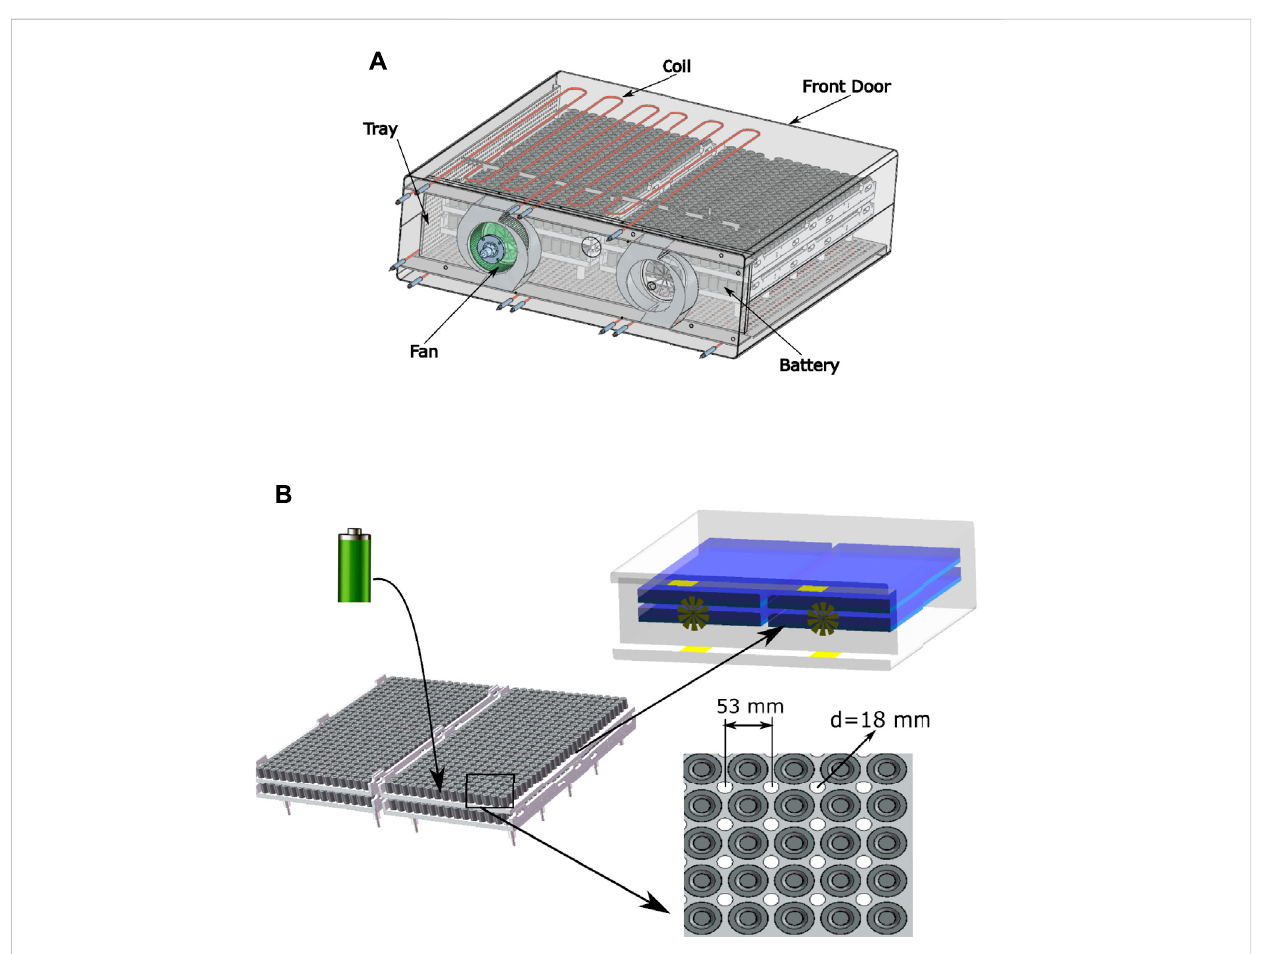
FIGURE 1 Illustrations of the drying cabinet investigated in the present work: (A) physical model that is mainly composed of fans, heating coils, porous plates, cylindrical batteries stacked on trays, and a front door for loading and unloading; (B) simpli fi ed model applied for CFD analysis.